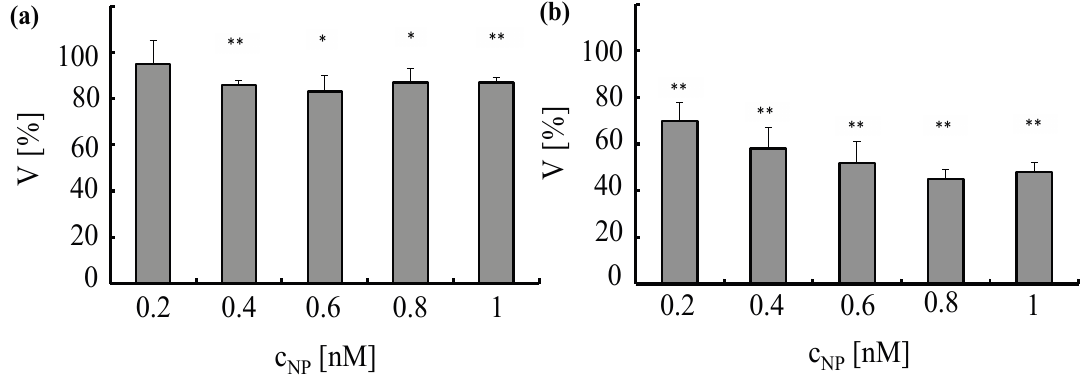
Figure 13. Toxicity induced by Au-PEG NPs in A549 cells ( a ) and HUVECs ( b )Au-PEG NPs, at concentrations ranging from c NP = 0.2 to 1 nM, were incubated for 4 h with A549 cells or HUVECs in media containing serum. Cell viability (V) was determined 24 h after adding the NPs to the cells. The viability was normalized to 100% for untreated control cells, * p < 0.01; ** p < 0.001(versus control